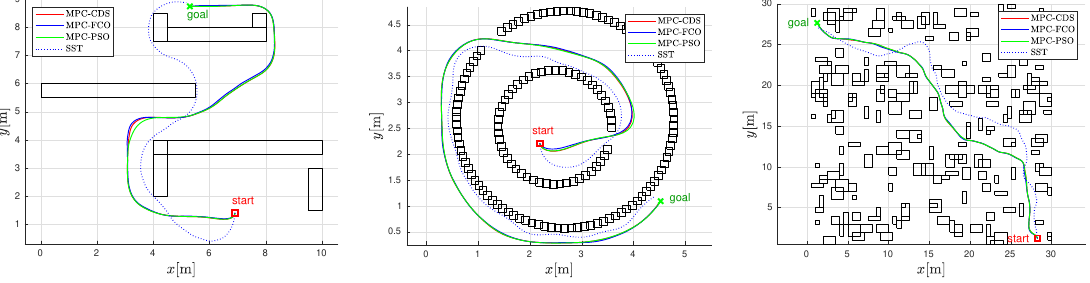
Figure 8. Trajectory comparison for the U-obstacle map (left), the Maze map (middle), the Random- obstacle map (right), the bicubic interpolated navigation, and the SST algorithm.